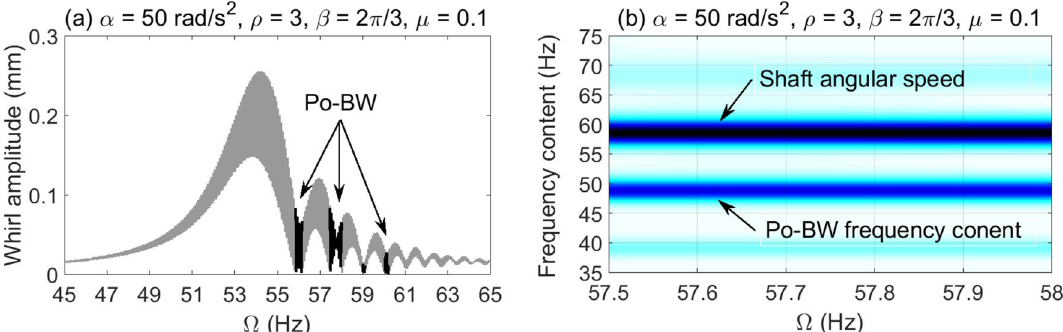
Figure 11. Po-BW zones of rotational speeds of an overhung cracked rotor system shown in the whirl amplitudes in ( a ), and the corresponding wavelet spectrum transform of the second Po-BW zone in ( b ) at 3 rad , and ρ = 3 . µ = 0.1 , α = 50 rad/s 2 , β = 2 π (cid:31)